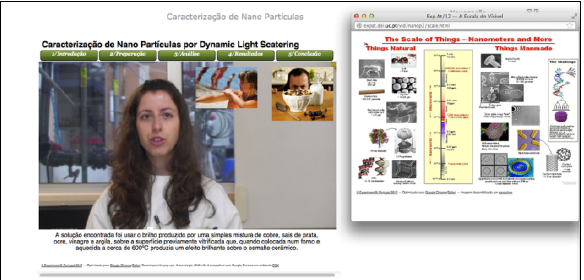
Figure 7. Interactive video: nanoparticles